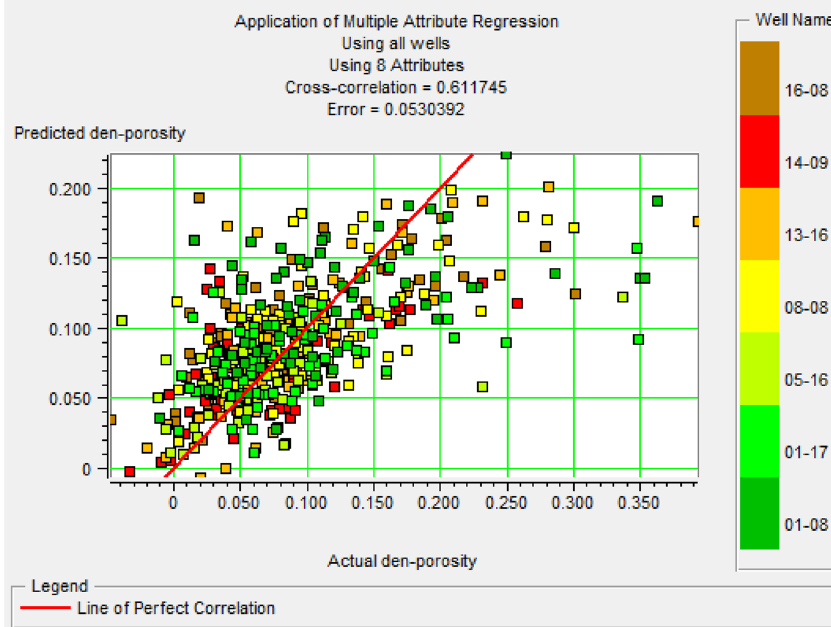
Fig. 17 Diagram of estimated porosity versus actual porosity for the second category data using multi-attribute regression